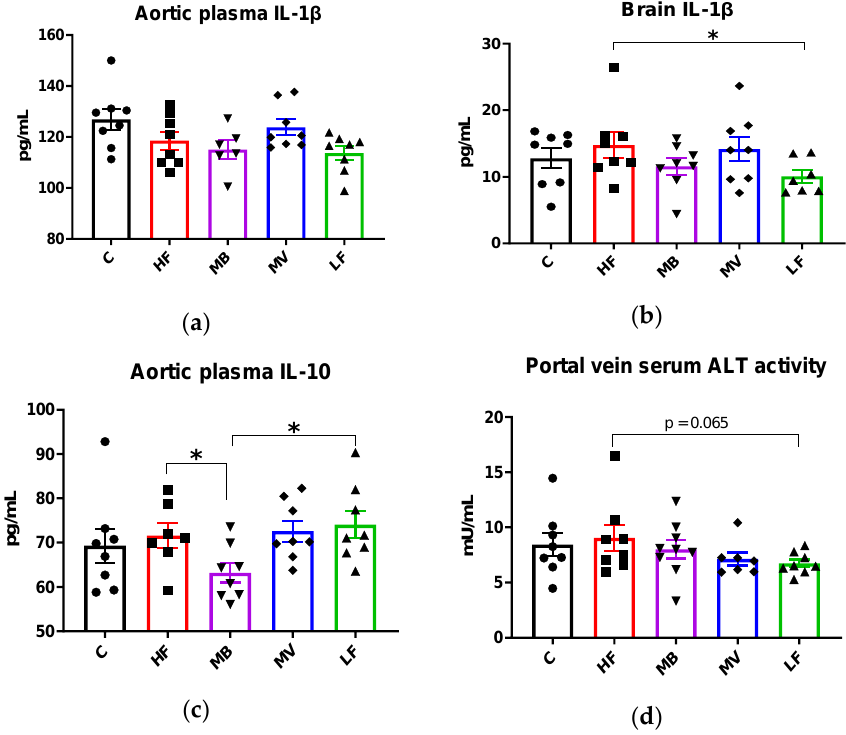
Figure 3. Changes in cytokines and liver enzymes in conventional rats fed a pure high-fat diet (C), or Apolipoprotein E-knockout (ApoE-/-) rats fed a low-fat diet (LF) or high-fat diet (HF), pure or supplemented with 1% monobutyrin (MB) or monovalerin (MV) for 5 weeks ( n = 8/group). Interleukin-1beta (IL- 1β , pg/mL) in ( a ) aortic plasma and ( b ) brain homogenates, ( c ) aortic plasma IL- 10 (pg/mL), and ( d ) portal vein serum alanine transaminase activity (ALT) activity (mU/mL). Rats from the C, HF, MB, MV and LF groups are shown as , , , and , respectively. Data are presented as means ± SEM. * p < 0.05.